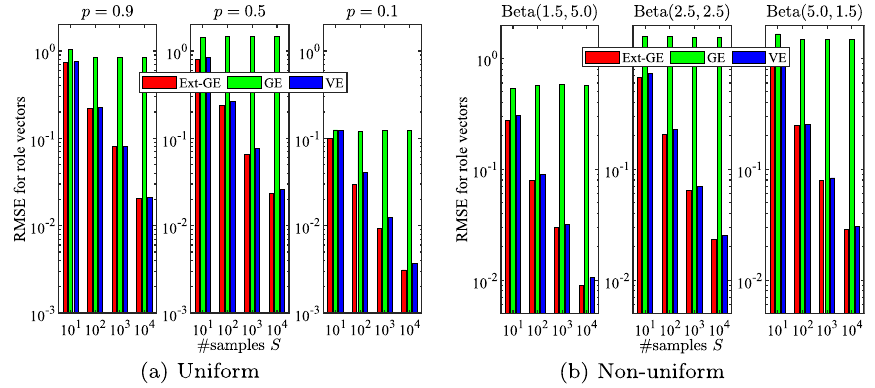
Fig. 9 RMSE of ensembled role vectors ¯ R against true role vectors